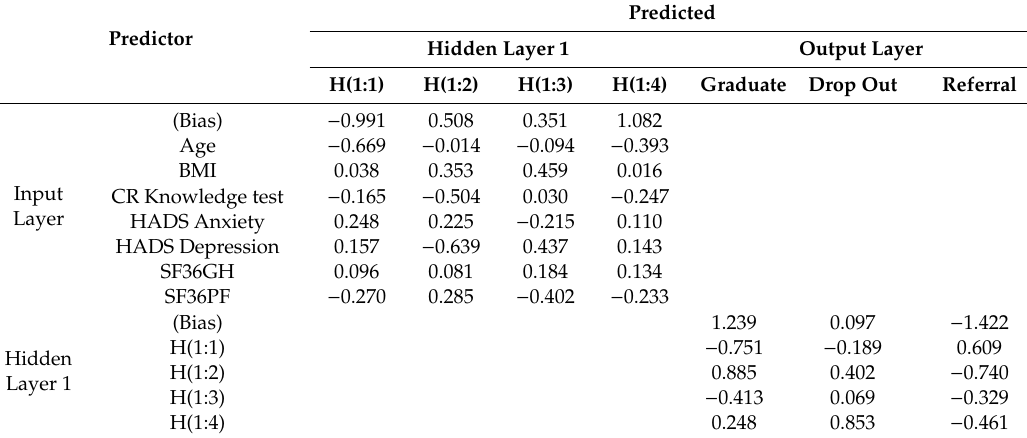
Table 4. ANN parameter